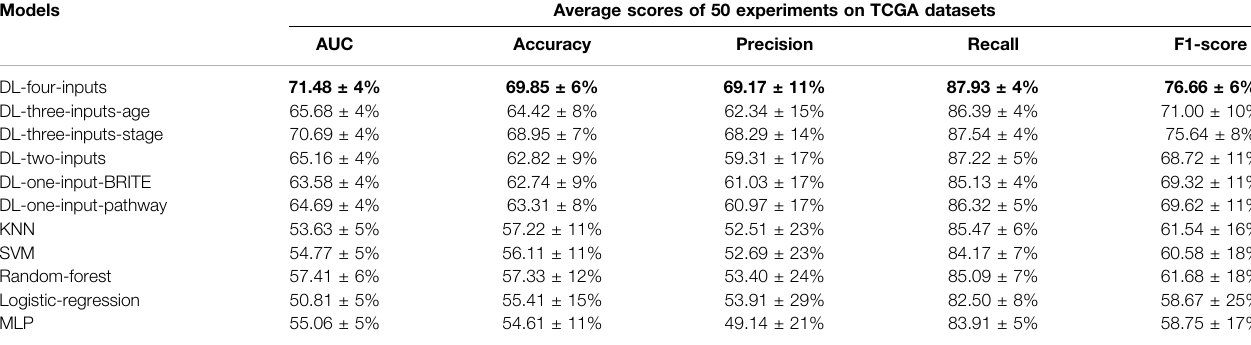
TABLE 3 | Results of the fi ve average metrics scores from 50 different train – test-split experiments (mean ± SD) on the TCGA lung cancer data set. The accuracy, precision, recall, and f1-score were calculated with the optimal threshold selected using Youden ’ s J statistic.